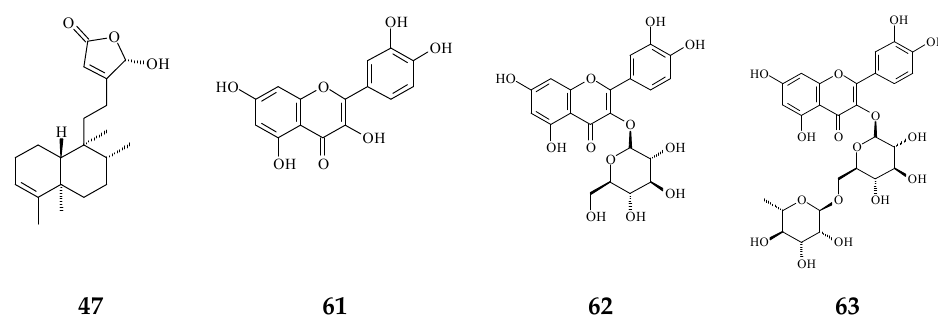
Figure 2. The phytochemical compounds isolated from species of Polyalthia with anti-oxidant activity (47 and 61–63).